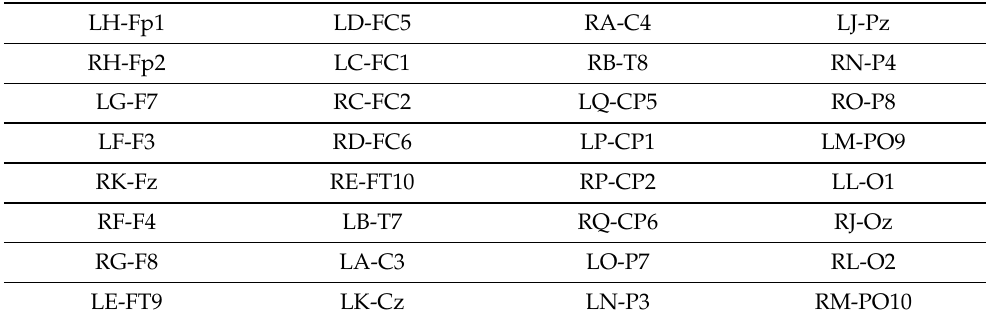
Table 2. Names of electrodes.